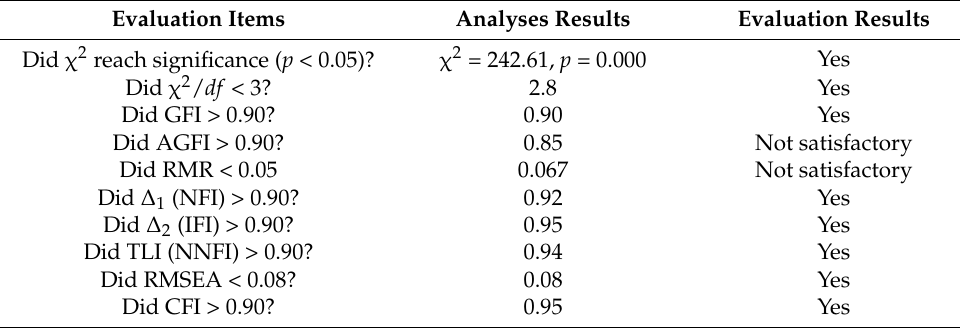
Table 3. Model evaluation measures of the overall model fit ( n =